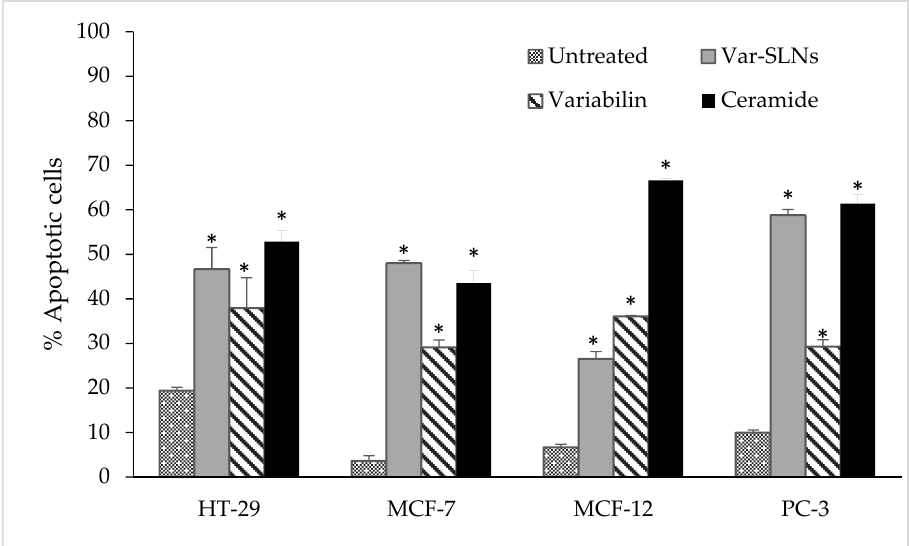
Figure 8. APOPercentageTM results obtained for variabilin (1) and Var-SLNs, together with ceramide (positive control) and untreated cells which served as a negative control. * Statistical significance ( p < 0.05).